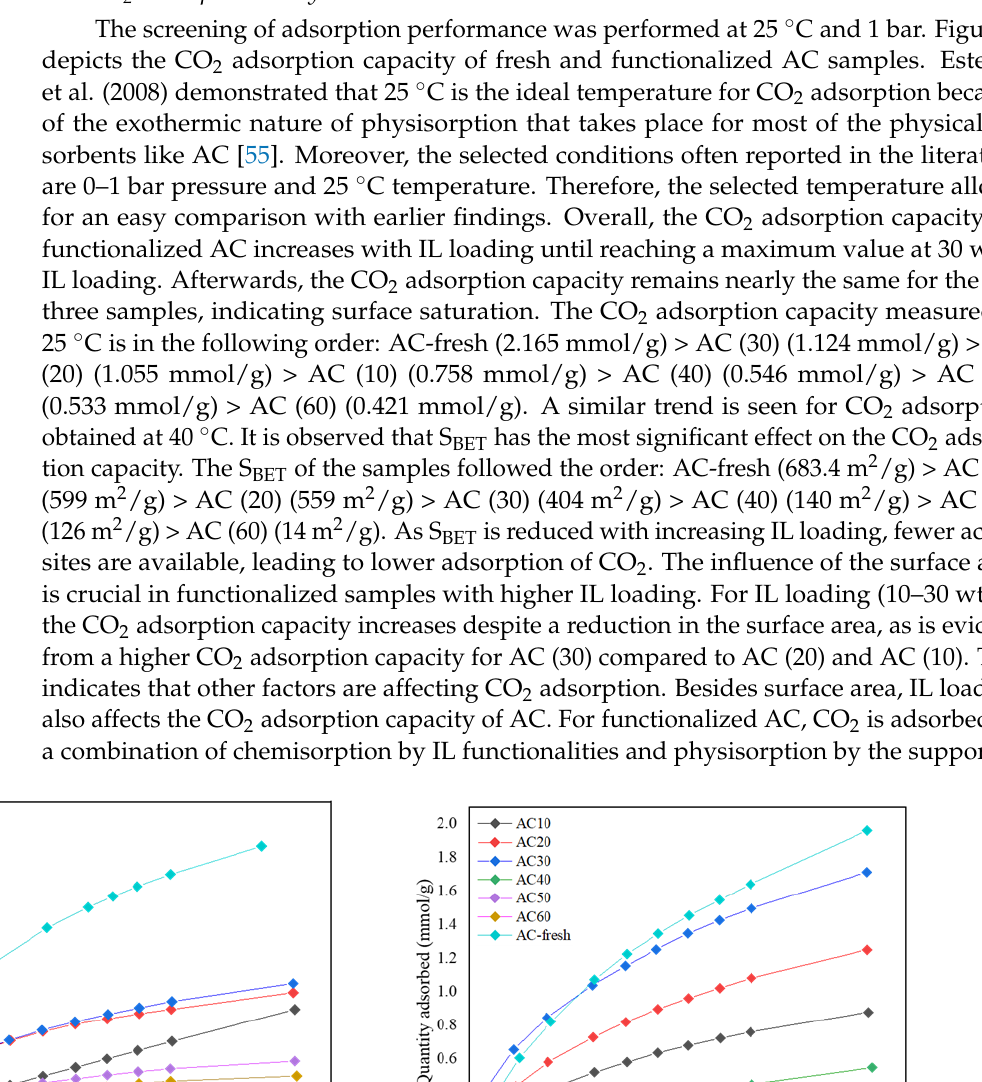
Figure 10. Percentage CO 2 uptake for fresh and functionalized AC obtained at ( a ) 25 °C and ( b ) 40 °C.